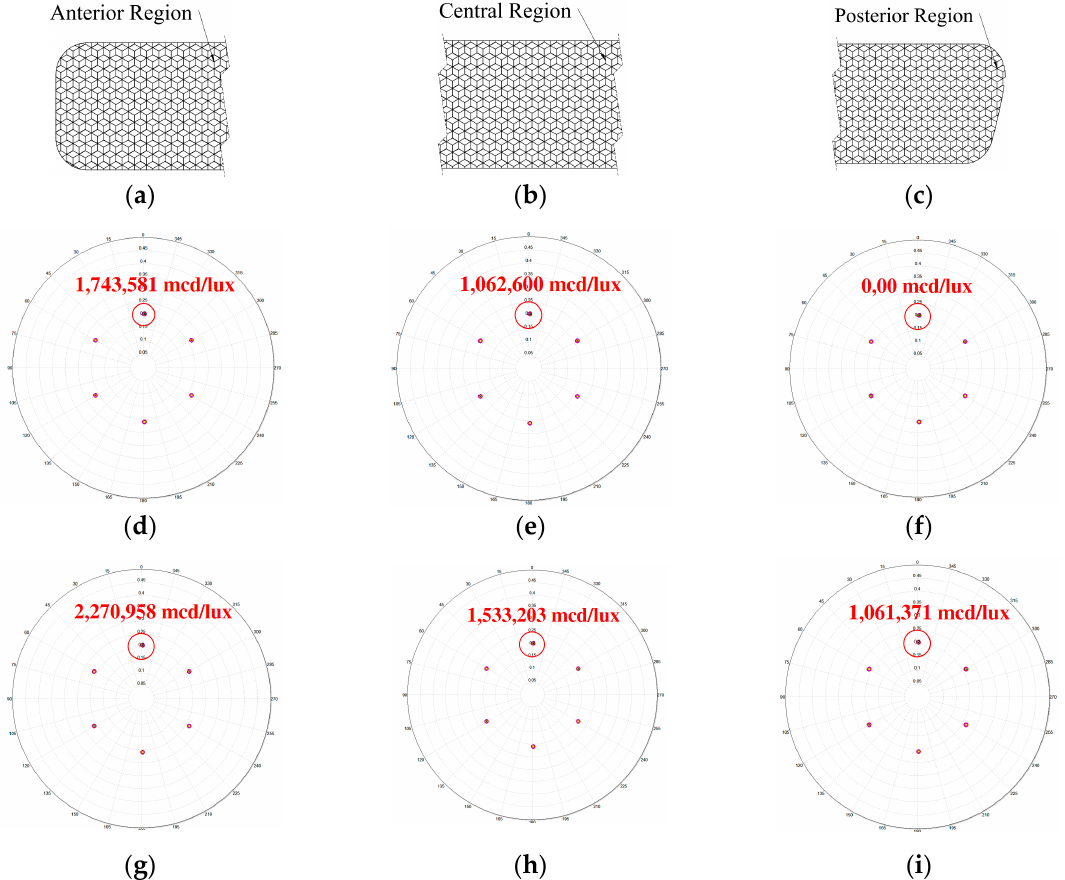
Figure 22. Reflected light intensity distributions and R I for 0° incident light beam on ( a ) anterior, ( b ) central, and ( c ) posterior regions of ( d – f ) the commercial CCCR and ( g – i ) the optimized CCCR, respectively.